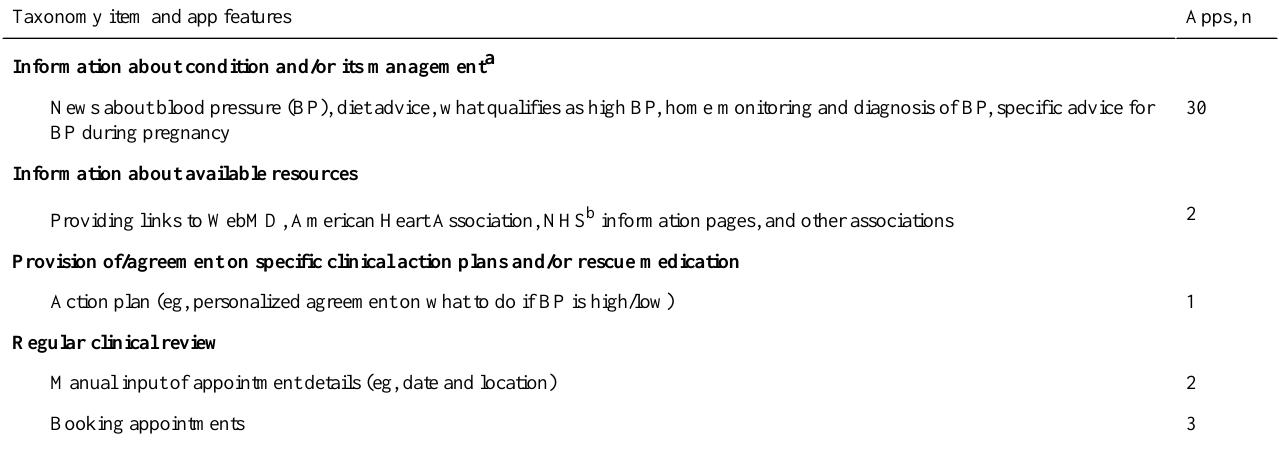
Table 1. Application features categorized by the Practical Reviews in Self-Management Support (PRISMS) taxonomy.